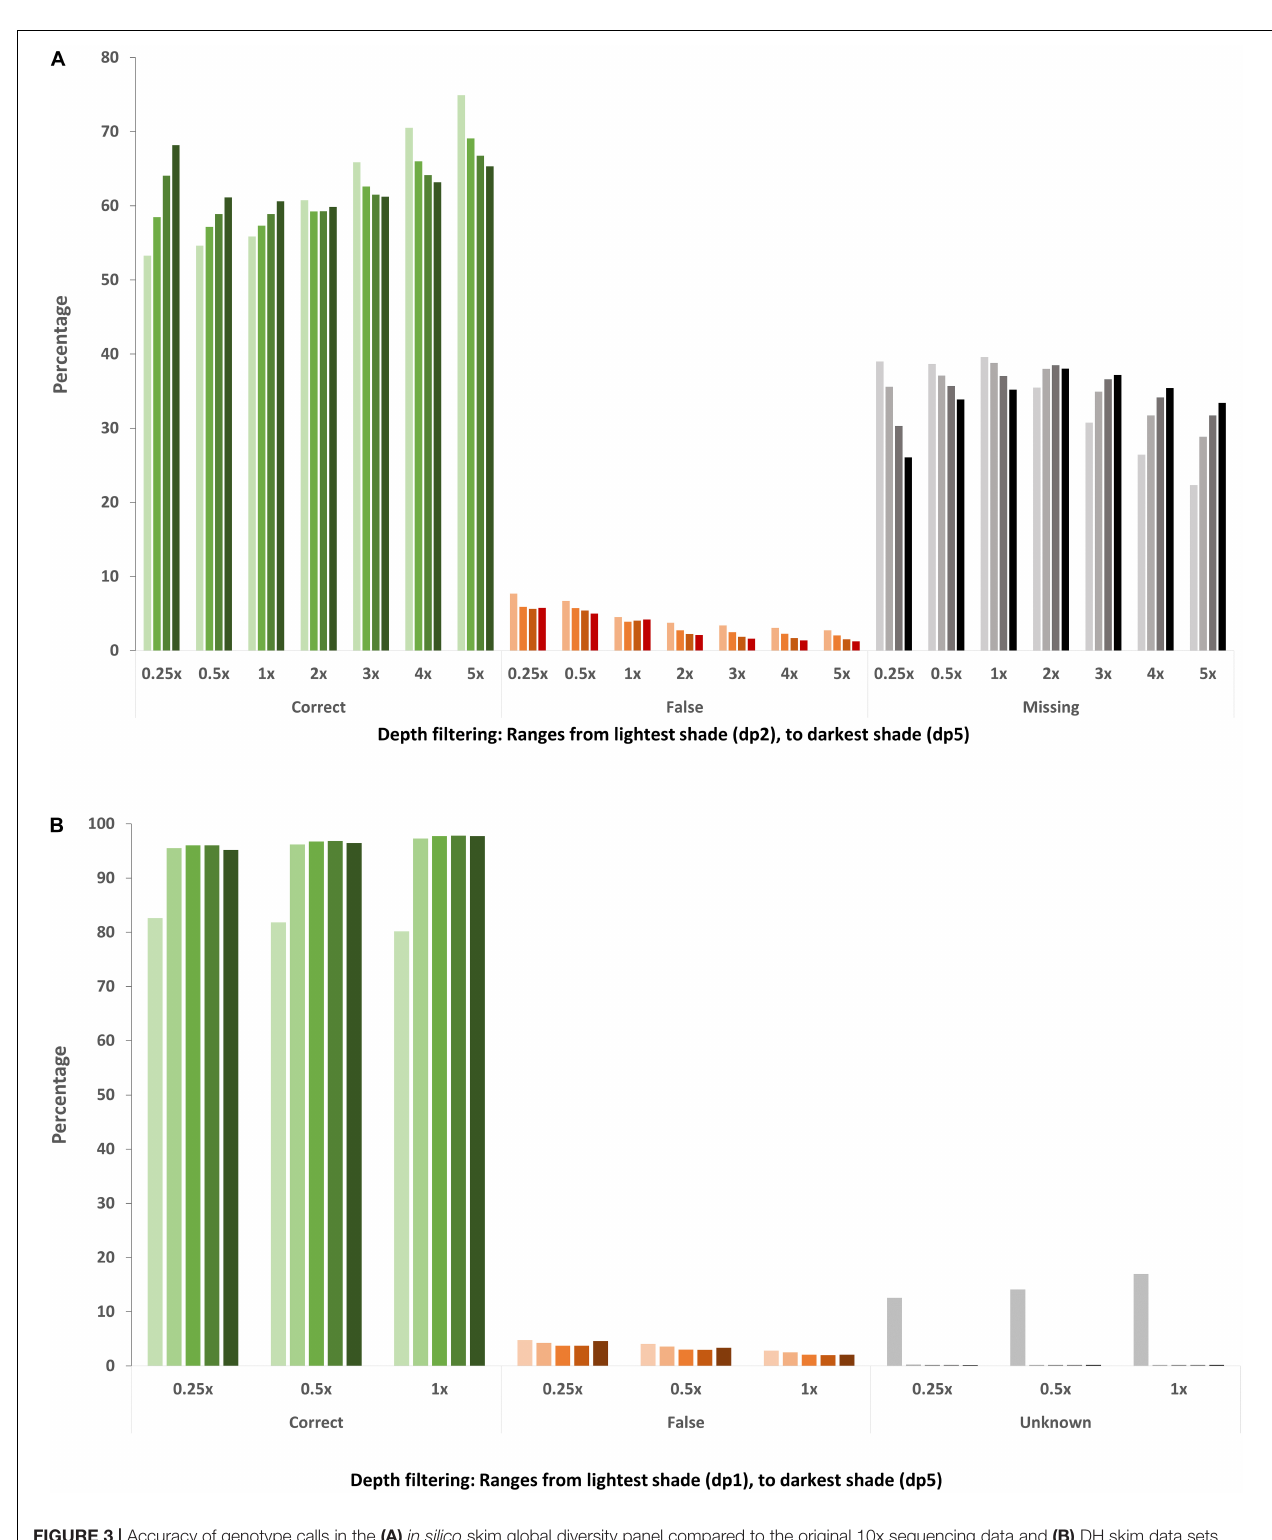
FIGURE 3 | Accuracy of genotype calls in the (A) in silico skim global diversity panel compared to the original 10x sequencing data and (B) DH skim data sets compared to the original 2x DH sequencing data. The percentage of genotypes across the whole genotype matrix (each SNP in each individual) within each skim SNP set is represented. Green bars represent genotype calls which are consistent with the corresponding full sequencing data, orange bars represent genotype calls which do not match, and the gray/black bars indicate missing genotypes in the (A) in silico skim global diversity panel and (B) genotypes present in the DH skim data but which could not be evaluated for accuracy due to insufficient read depth in the original 2x